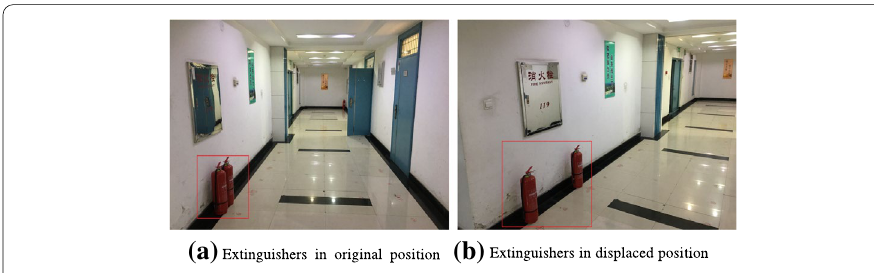
Fig. 5 Example for the displaced